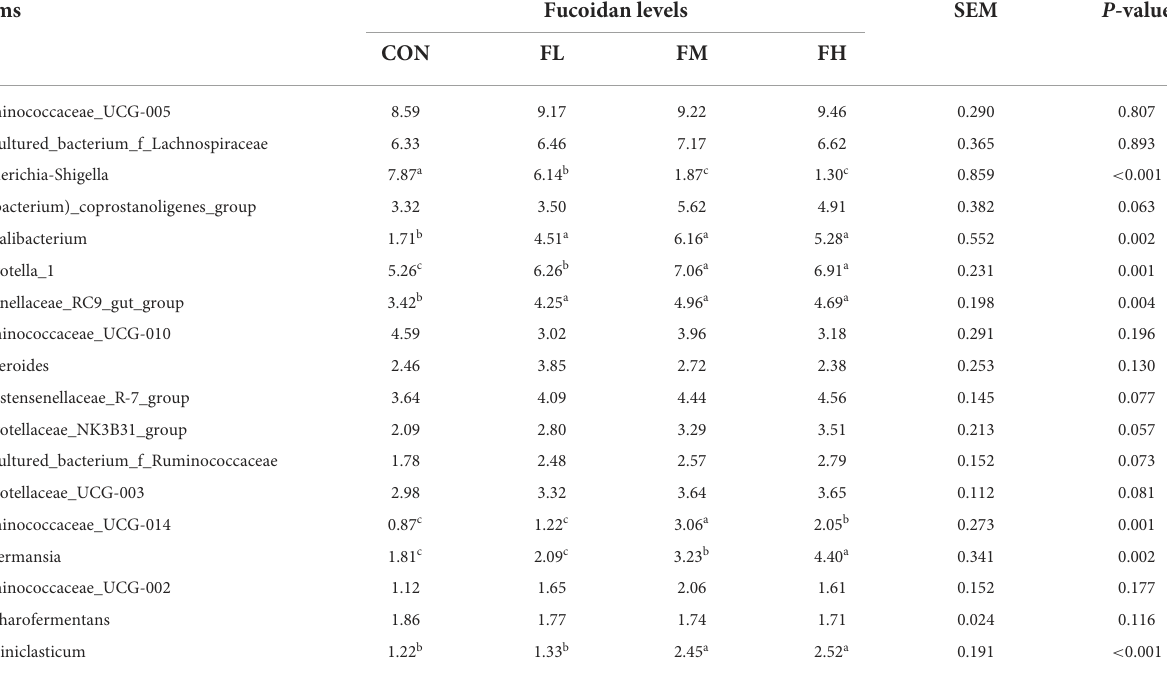
TABLE 4 The effects of fucoidan on the major bacterial genera in the compositions of the ceca (average relative abundance ≥ 1% in at least one group) (%).